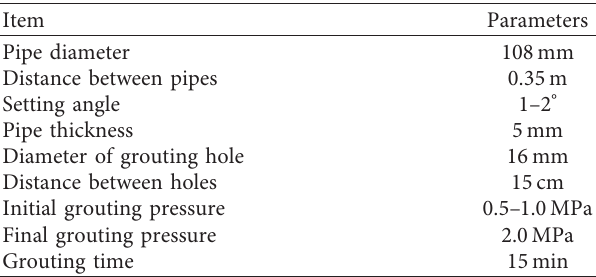
Figure 10: Sketch map of long pipe roof setting. Table 2: Parameters of pipe